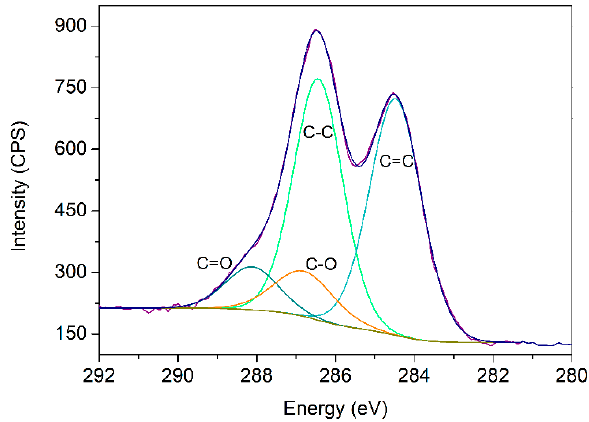
Figure 4. GO-Fitted XPS spectra of C 1s and its deconvolution. Blue line corresponds to the fitted curve.